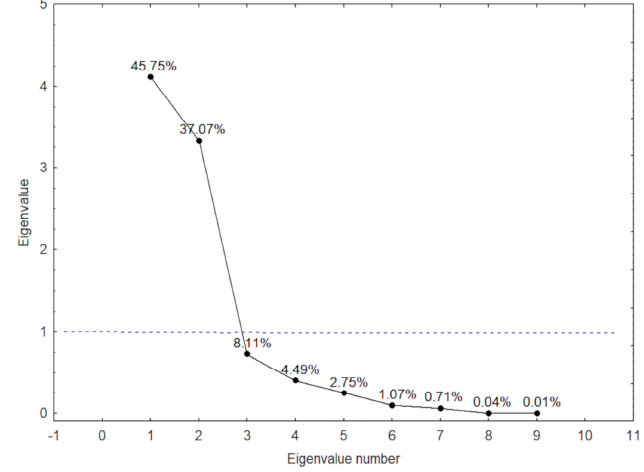
Figure 1. Significance assessment among laboratory biomarkers in patients with sickle leg ulcers or previous history (SLU+) obtained by eigenvalues to Principal Component Analysis (PCA) results. Table 4. Laboratory parameters associated with SLU determined by PCA.